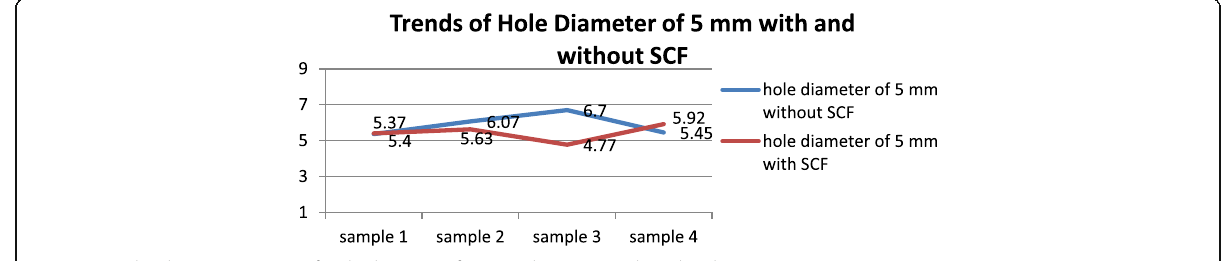
Fig. 14 Graphical Representation of Hole diameter of 5 mm Glass Pane with and without